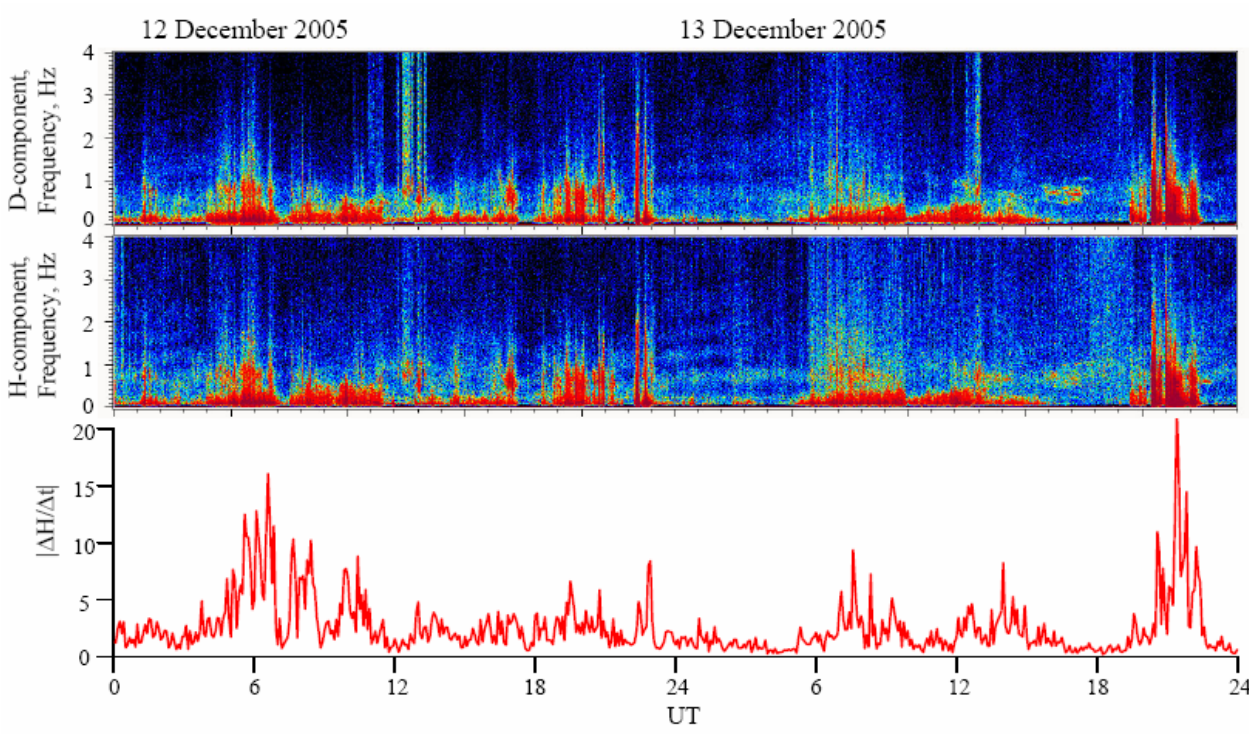
Fig. 2. The same as in Fig. 1 but for 12 December 2005 and 13 December 2005.